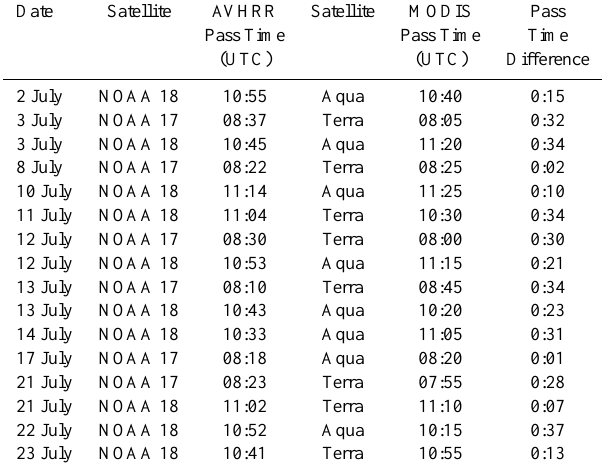
Table 1. Dates and time passes of Terra, Aqua, NOAA 17 and NOAA 18 acquisitions used in this study. The pass time difference is between 7 and